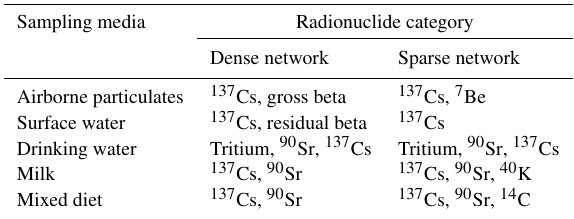
Table 2. Sample types and measurements as recommended in 2000/473/Euratom